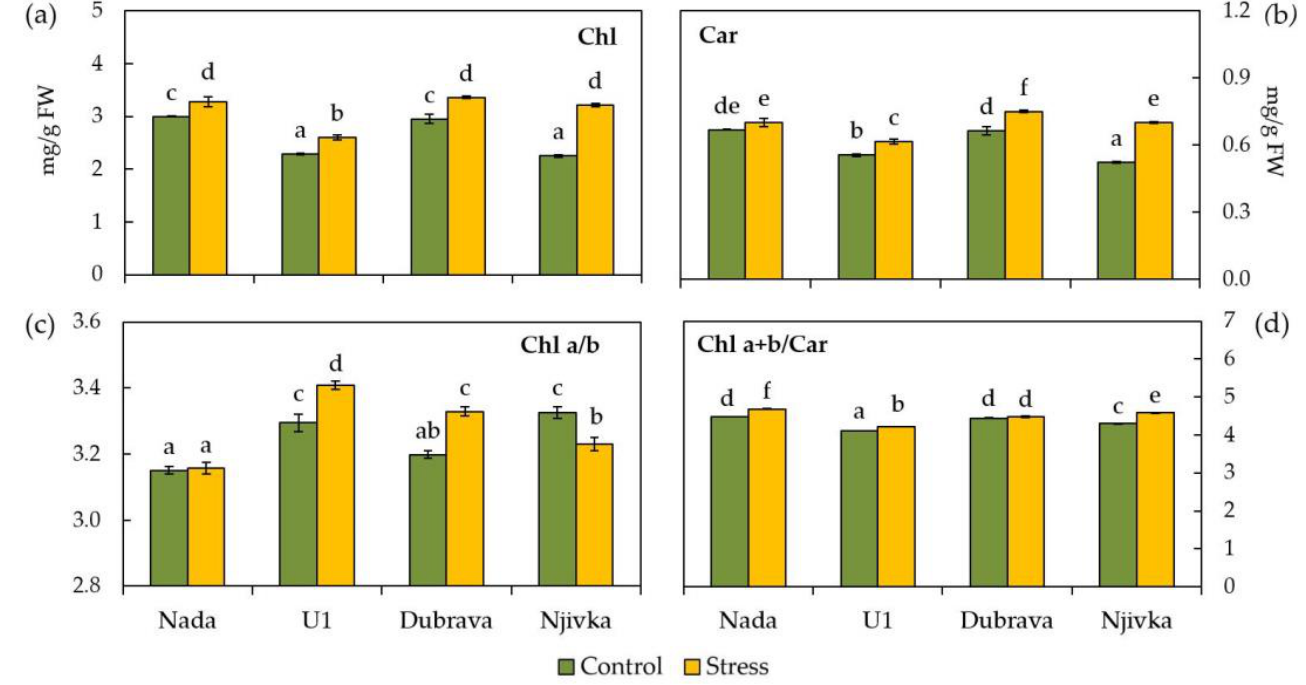
Figure 5. Total chlorophylls (Chl a + b ) ( a ), carotenoids (Car) ( b ), chlorophyll a / b ratio (Chl a / b ) ( c ), and total chlorophylls/carotenoids ( d ) in control and drought stressed flag leaves of wheat cultivars. Bars represent mean values ± SE. Different letters indicate a significant difference among treatments and cultivars at p < 0.05 according to LSD test.